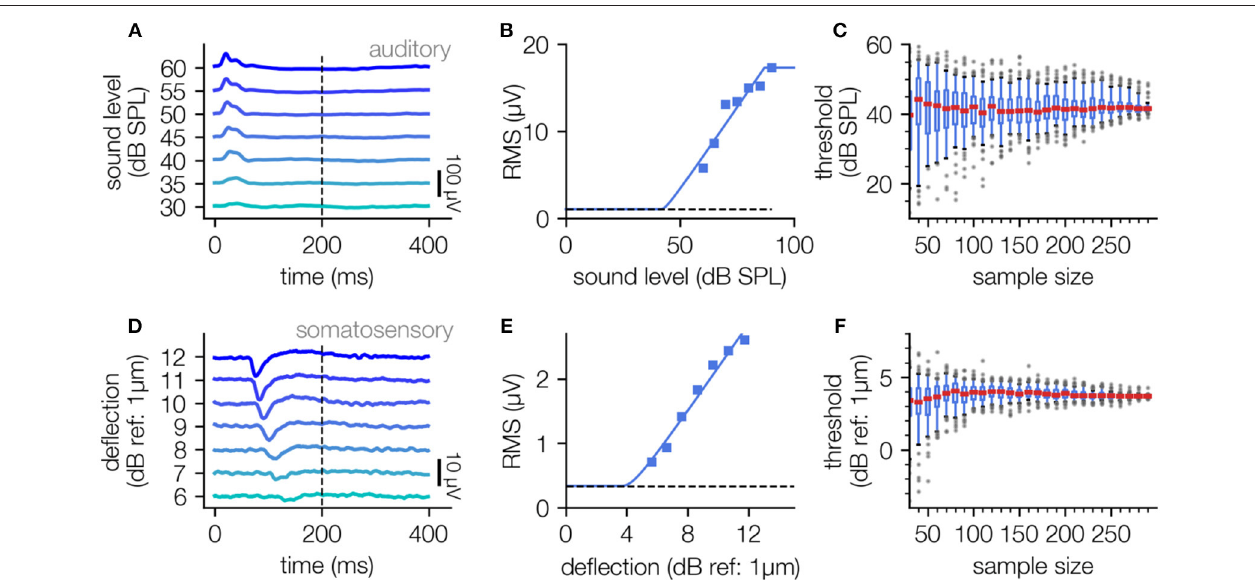
FIGURE 5 | Threshold determination using LFP data recorded in auditory and somatosensory cortex. ( A–C) , Determination of neuronal thresholds in the auditory cortex; (A) LFP responses to 2kHz tones of 200ms duration and varying sound pressure level (30–60 dB SPL). (B) Level response function approximated using the hard sigmoid fit. (C) , Estimated threshold as a function of sample size (100 subsamples each). (D–F) : Analog analysis for LFP responses to vibro-tactile stimuli (200ms, 175Hz) of different amplitudes (6–12 dB) in the somatosensory cortex.